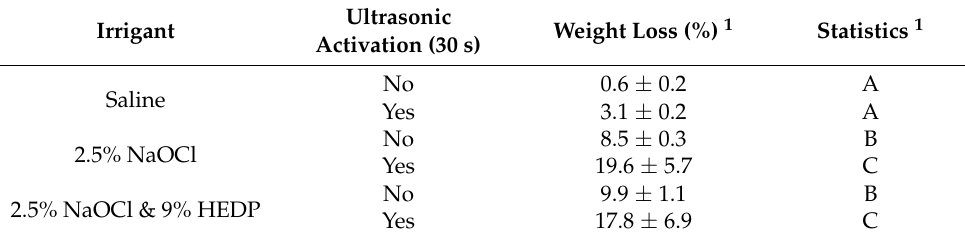
Table 2. Soft tissue weight loss when shrimp tissue pieces were suspended in test or control irrigants in Eppendorf tubes placed in the ultrasonic water bath (38 ◦ C, 37 kHz) and were then activated or left non-activated for 30 s.